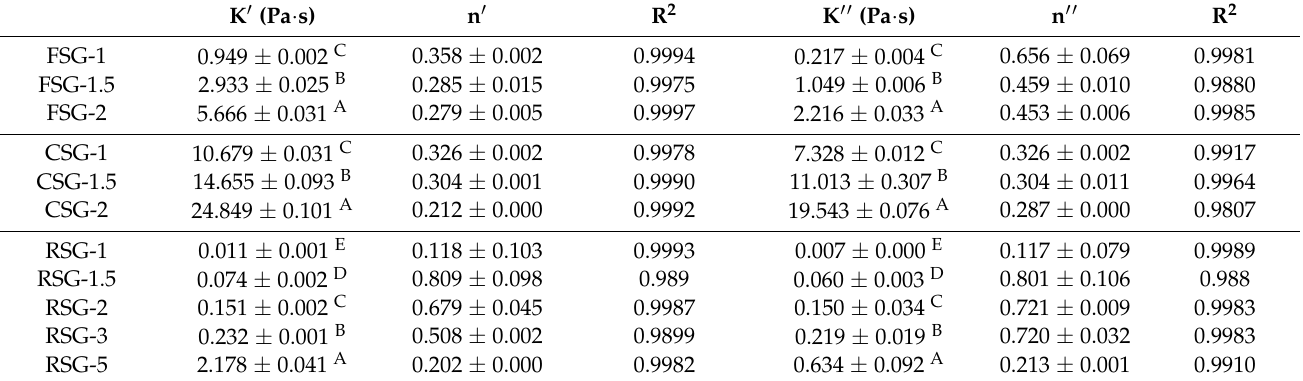
Table 5. Power-law parameters of dynamic rheological properties of the CSG, FSG, and RSG solutions.